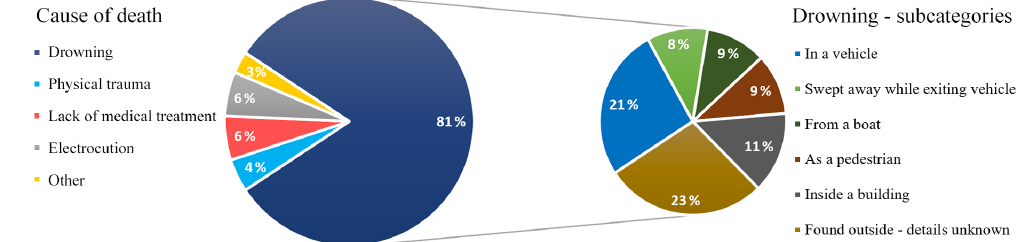
Figure 3. Causes of death for Hurricane Harvey ( n =